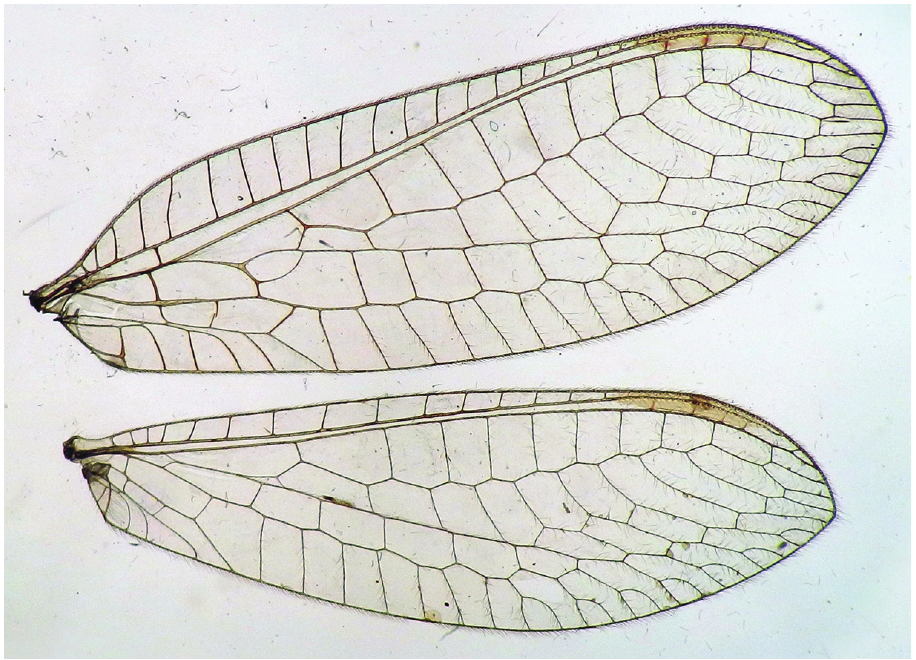
Figure 94. Ungla yutajensis Sosa: Wings (Venezuela, Amazonas, holotype, female, MIZA, images FS).